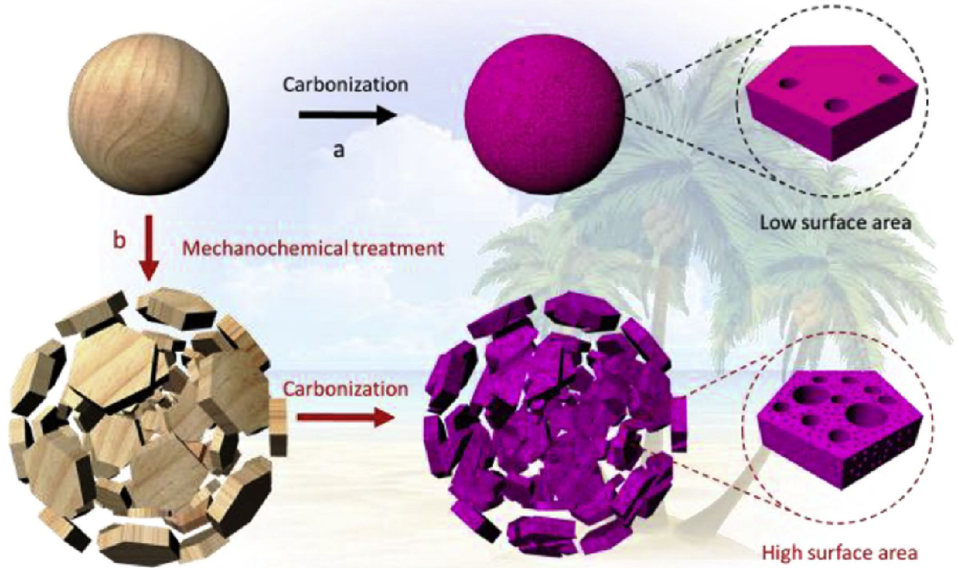
Figure 15. Comparison of surface modification of BC-based materials by carbonization and its combination with the ball milling method. Route ( a ) carbonization, Route ( b ) mechano-chemical treatment followed by carbonization. Reprinted with permission from Ref. [237]. Copyright © 2017 American Chemical Society.